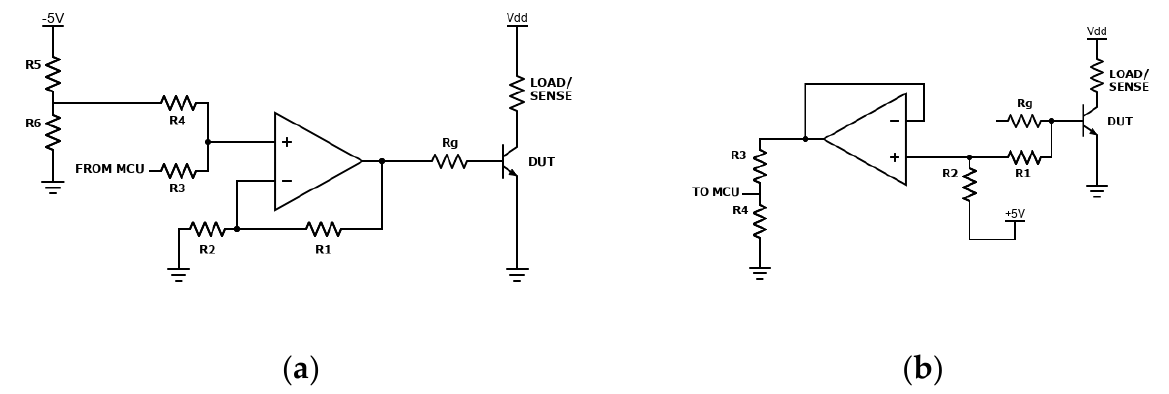
Figure 6. Gate circuits: ( a ) gate driving circuit; ( b ) gate voltage sensing circuit.